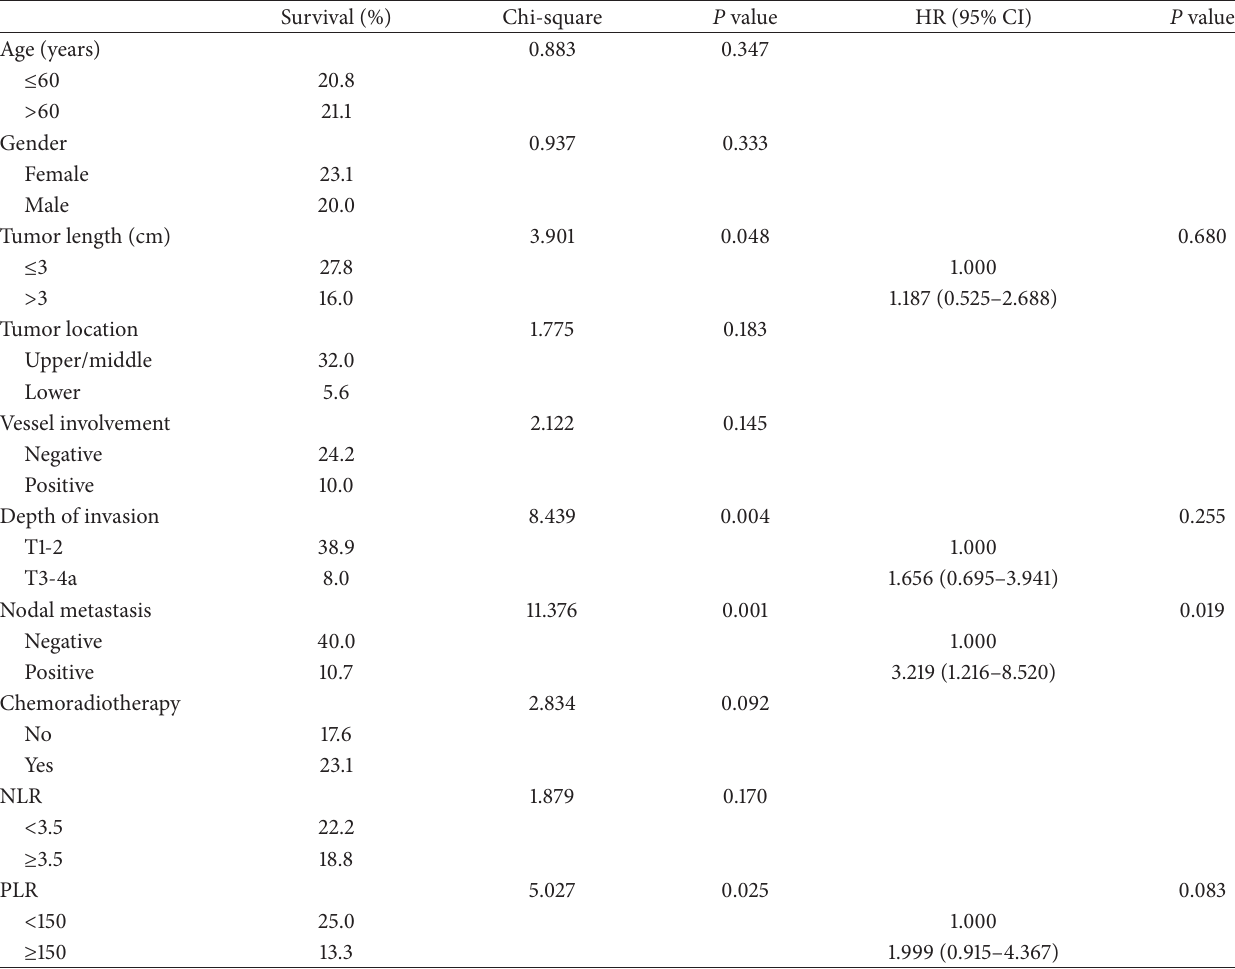
Table 2: Univariate and multivariate analyses of RFS in SCCE